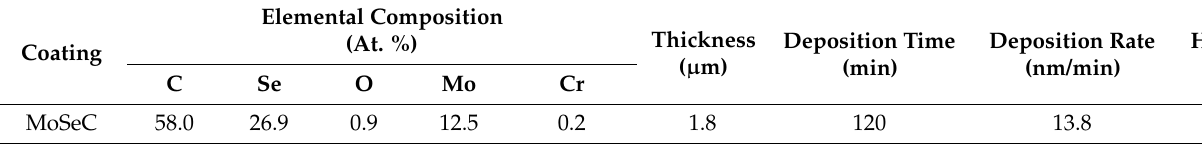
Table 3. Coating parameters used for MoSeC coating.